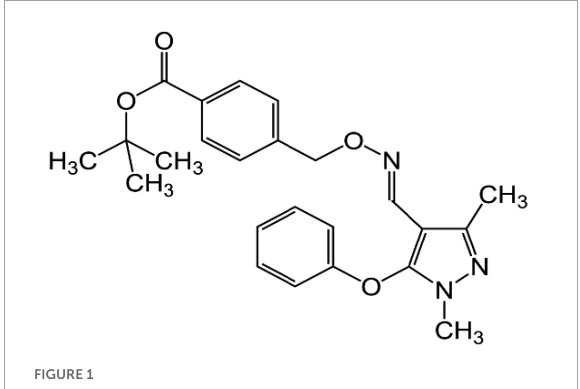
FIGURE1 Chemical structure of fenpyroximate (structure was created using